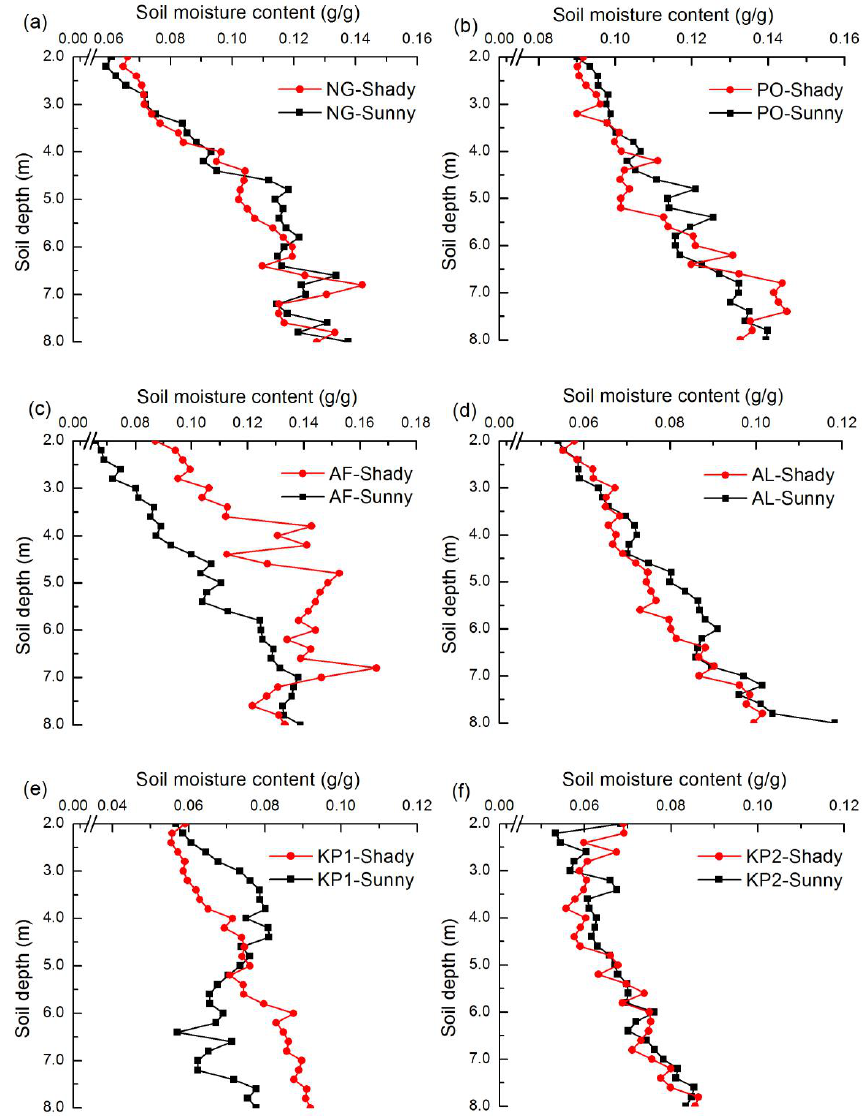
Fig. 5. Comparison of deep soil moisture content (SMC) on different slope aspects. Note: NG represents native grassland; PO represents farmland planted with potato; AF represents abandoned farmland; AL represents alfalfa; KP represents korshinsk peashrub. Sunny and shady refer to sunny slope and shady slope, respectively. For example, NG-Shady refers to native grassland on shady slope, and NG-Sunny refers to native grassland on sunny